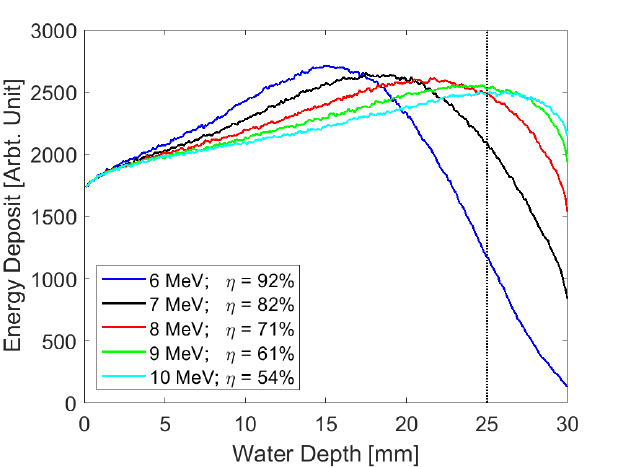
Figure 14. Single-sided irradiation with high-energy beams. η is the irradiation efficiency as defined in Equation